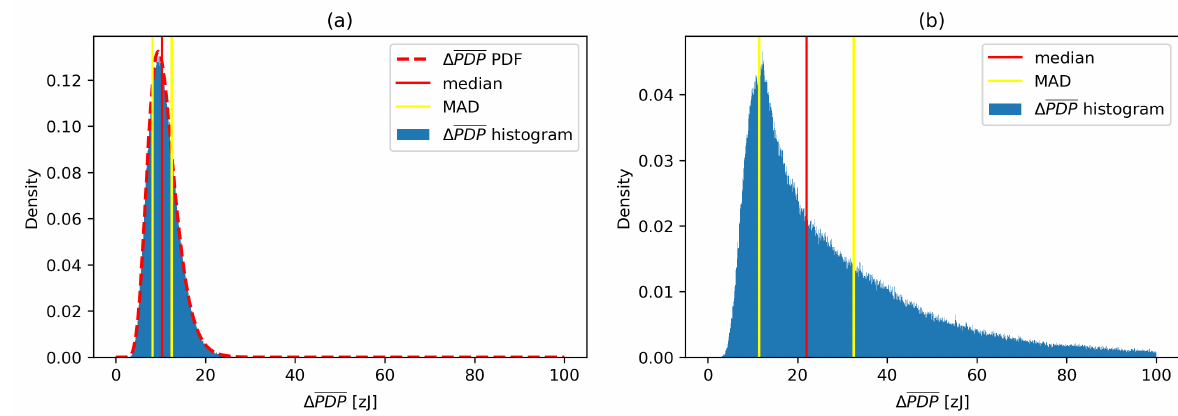
Figure 5. ∆ PDP histograms for the environment without ( a ) and with ( b ) movement.